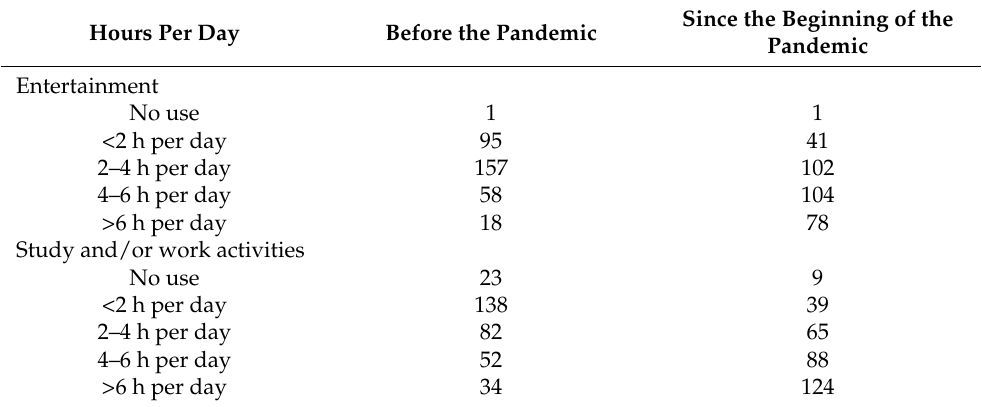
Table 2. Hours per day that emerging adults spent on the Internet for entertainment and study/work activities before and after the beginning of the COVID-19